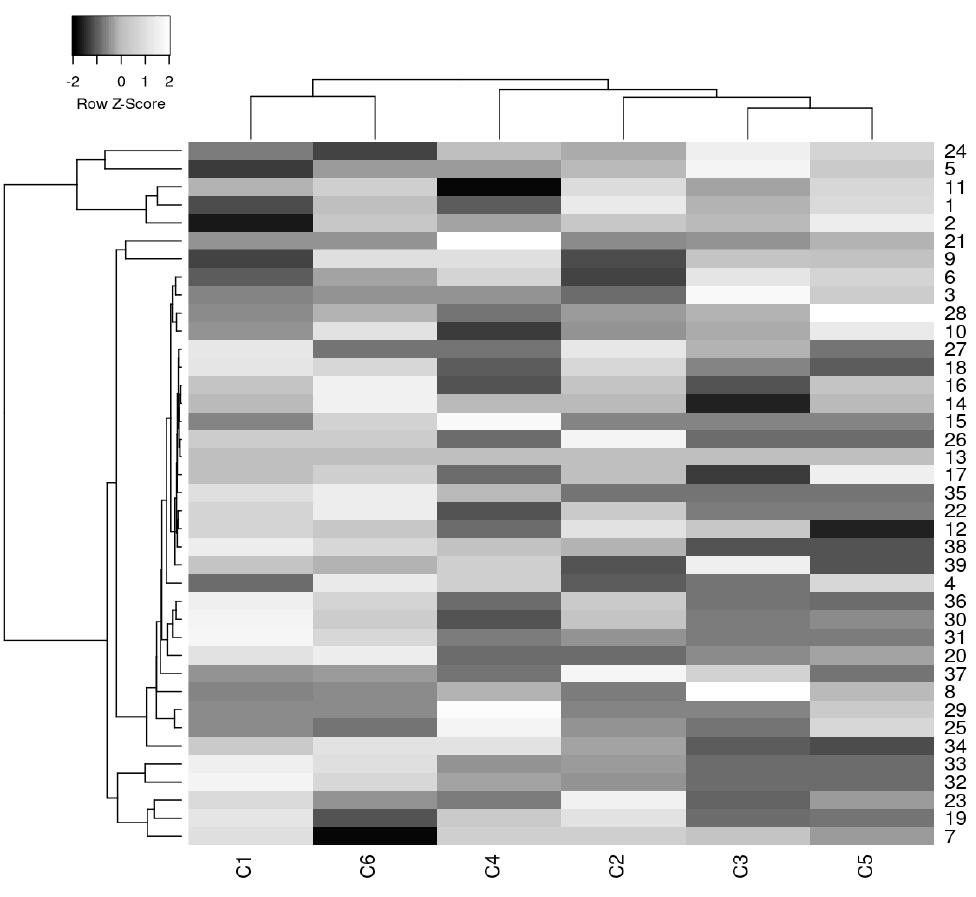
Figure 4. Hierarchical cluster analysis through heatmapping of coffee samples.